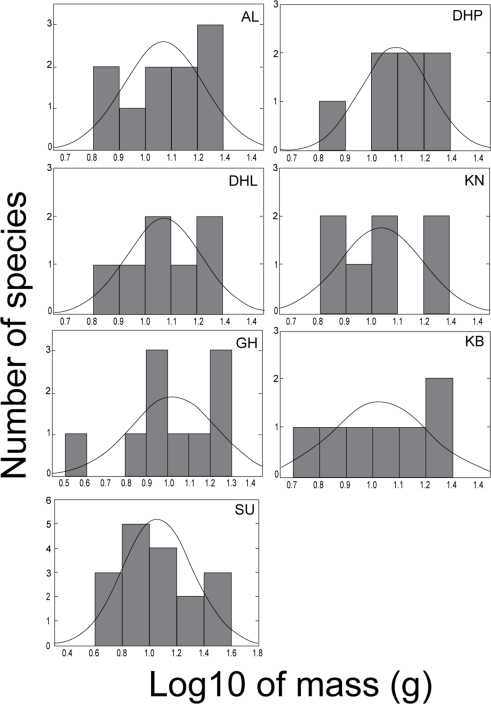
Distributions of body sizes of insectivorous bat species at the ensemble scale.The expected normal distribution curve is also shown..